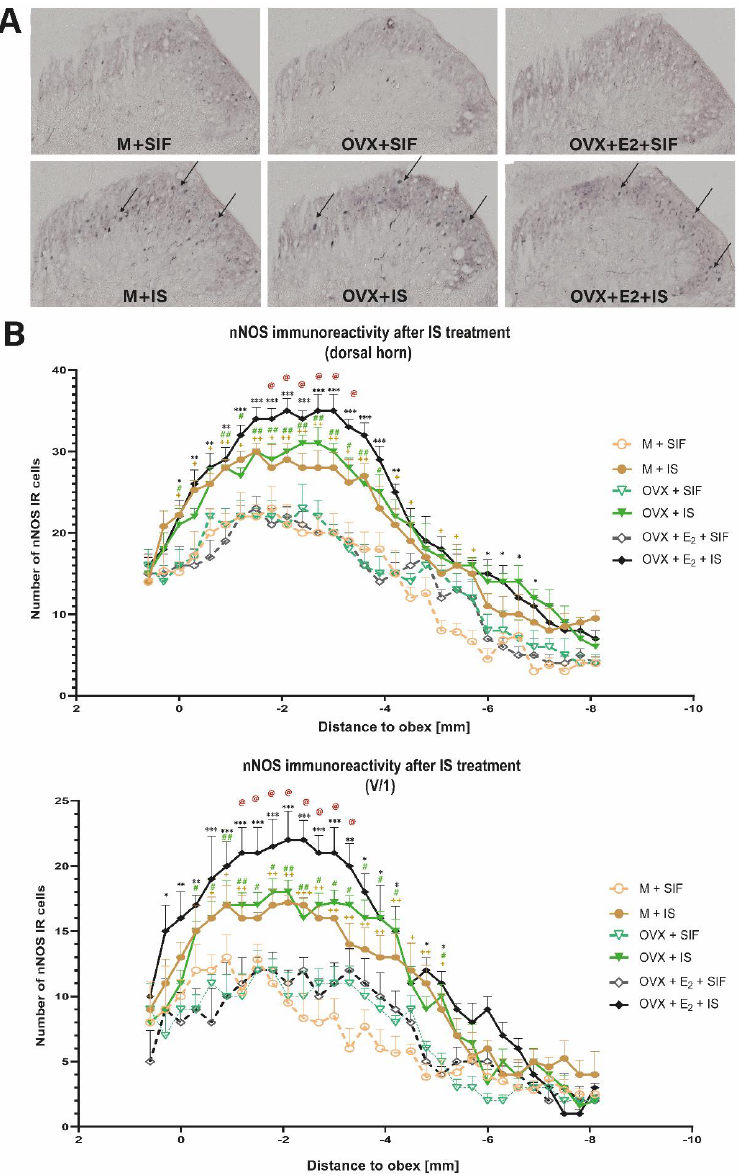
Figure 4. nNOS immunostaining. ( A ) Representative photomicrographs of the nNOS expression in